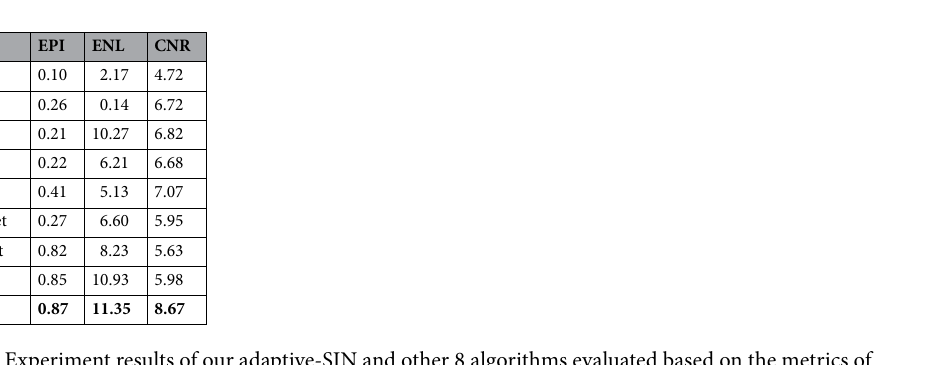
Figure 7. Normal sample images by our adaptive-SIN and other 8 algorithms for the performance evaluation. ( a ) the original image with noise, ( b ) the high-quality line-scan image as the reference to evaluate the denoised images, ( c – g ) results by traditional machine learning algorithms ASR, SBD, K-SVD BM4D, and cGAN respectively, ( h ) the result by the proposed algorithm.